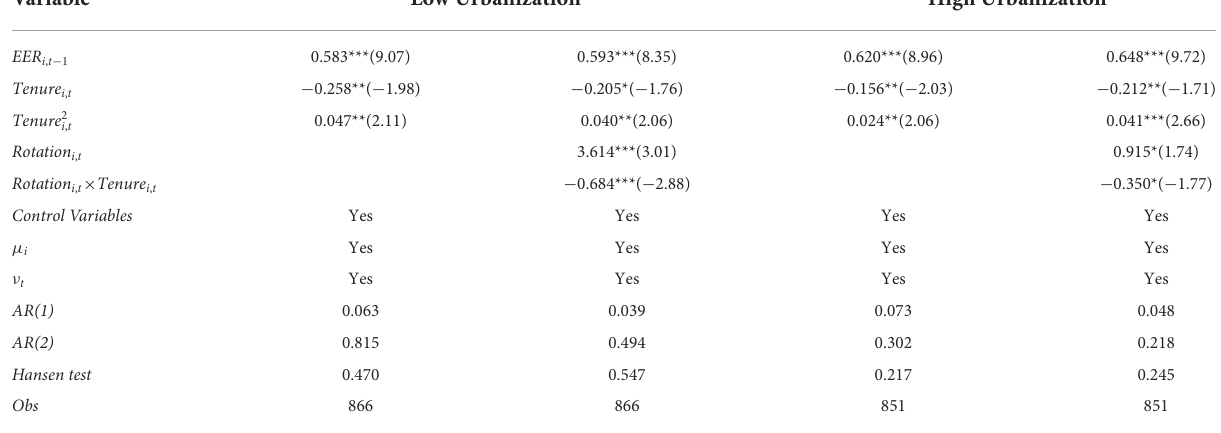
TABLE 5 Empirical results of official compliance heterogeneity